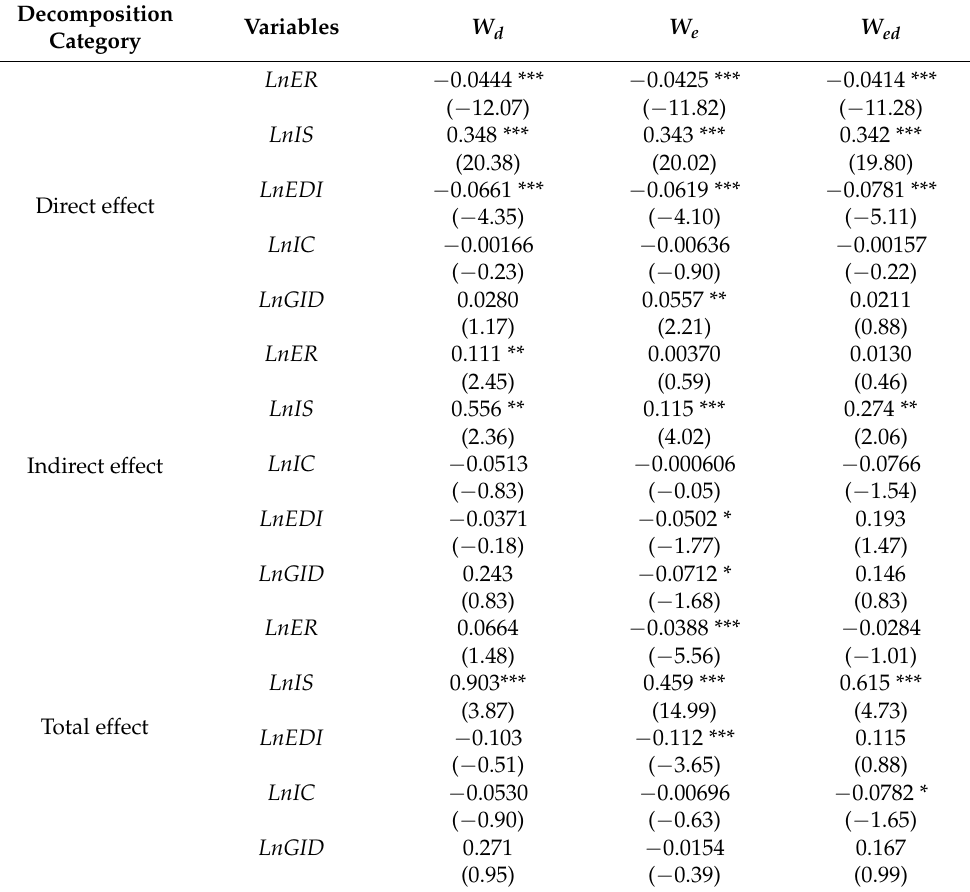
Table 5. Parametric decomposition of spatial spillover